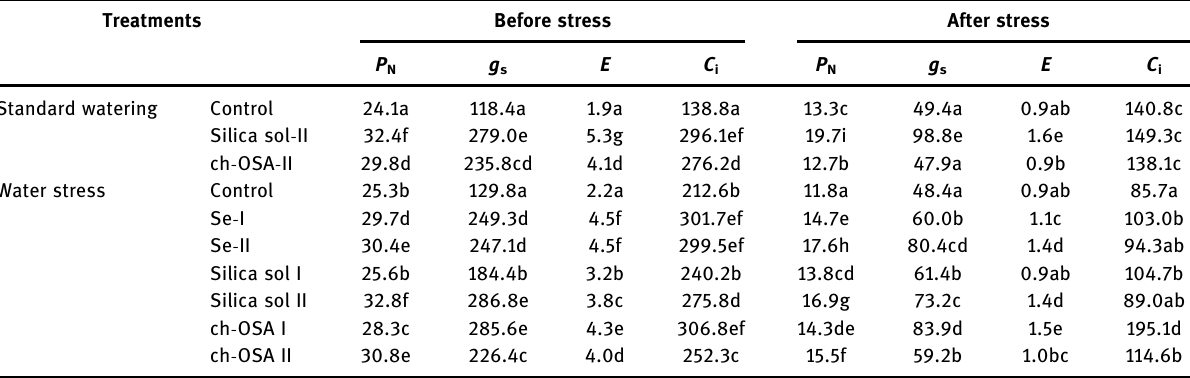
Table 3: Gas exchange parameters of Tagetes patula L. “ Pascal ” of applied combinations ( P N – net photosynthesis activity ( µmol ( CO ) m − 2 s − 1 ) ; g – stomatal conductance ( µmol m − 2 s − 1 ) , E – transpiration rate ( µmol ( H 2 s